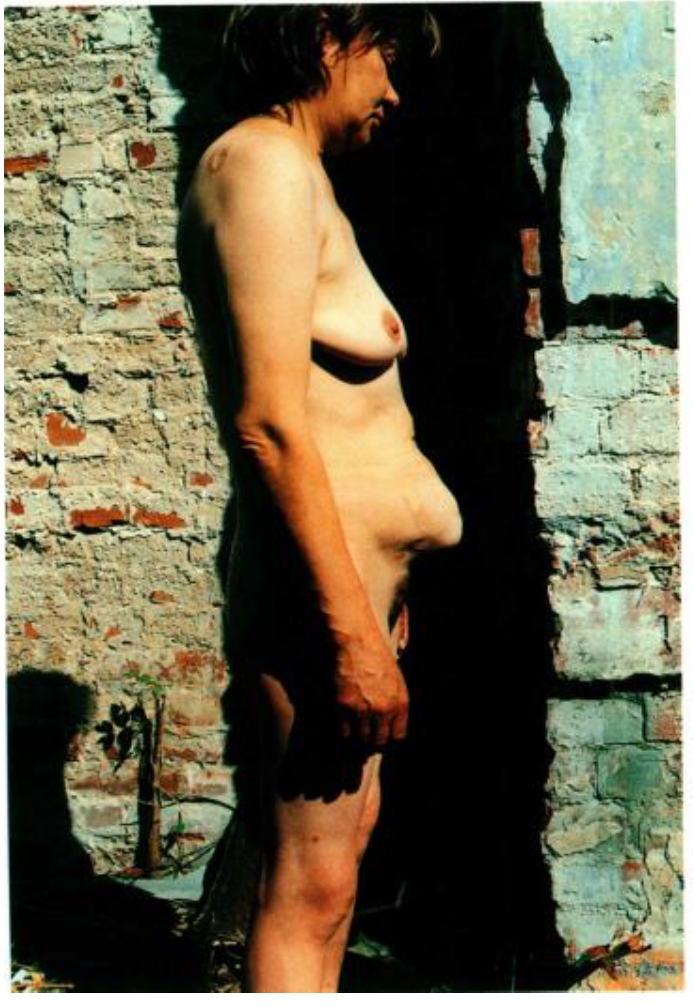
Boris Mikhailov, Untitled , from the series Case History (1997 – 98). Chromogenic color print, dimensions variable. Copyright Boris Mikhailov; courtesy Pace/MacGill Gallery, New